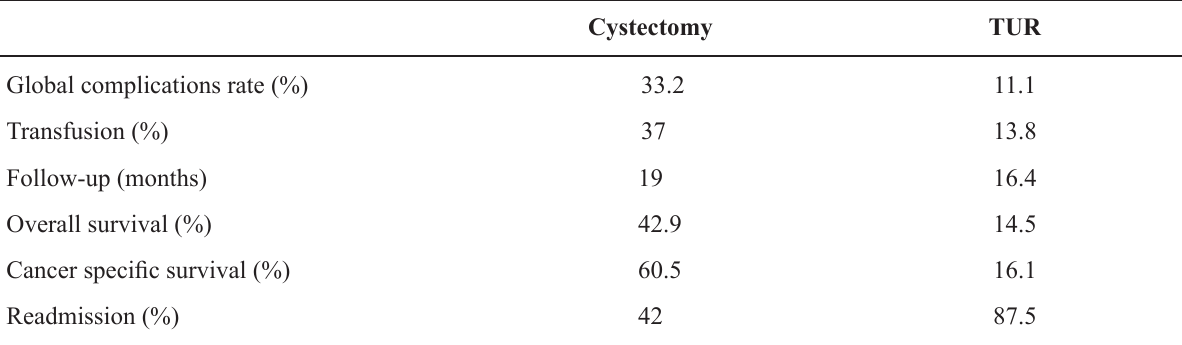
Table 2 – Complications rate and oncological outcomes in RC and TUR